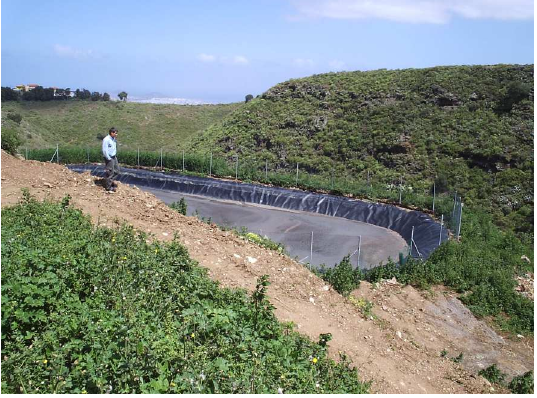
Figure 5. Photograph of Plant 1, with a detail of the pond.